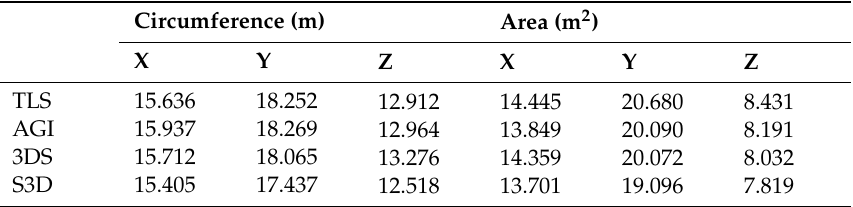
Table 4. Boulder No. 1: circumference and the section area.